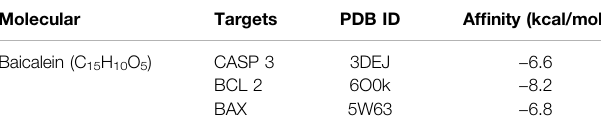
TABLE 1 | Binding energies of Baicalein and BAX, BCL2, and CASP3. Molecular Targets